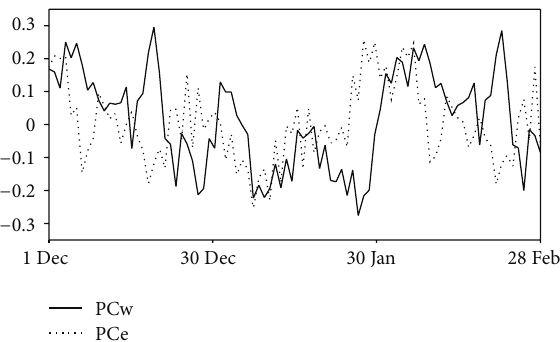
Figure 9: The variability of the WSE and ESE (solid line: PCw, pecked line: PCe) for the winters of 1948–2010, which are obtained throughthesamecalendardaymeanofPCwandPCe(standardized, unit: